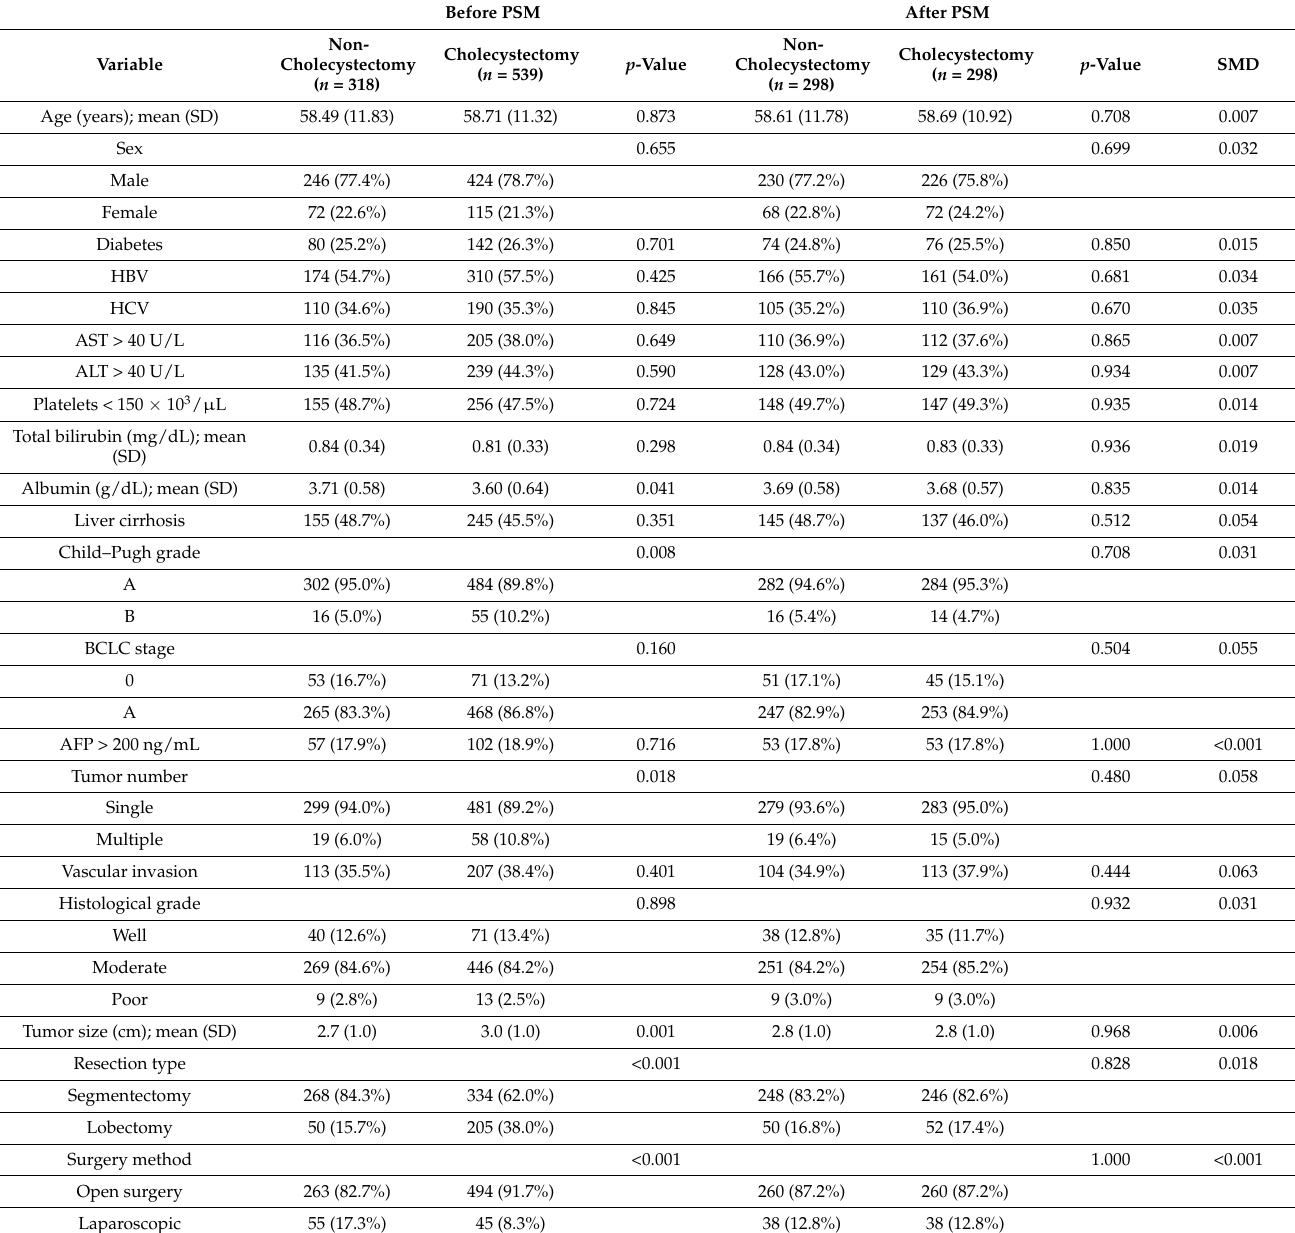
Table 1. Patient Characteristics Before and After Propensity Score Matching. Data are expressed as mean ± standard deviation or n (%). Abbreviations: PSM; propensity score matching; HBV, hepatitis B virus; HCV, hepatitis C virus; AST, aspartate aminotransferase; ALT, alanine aminotransferase; BCLC, Barcelona Clinic Liver Cancer; AFP, alpha fetoprotein; SMD, standardized mean